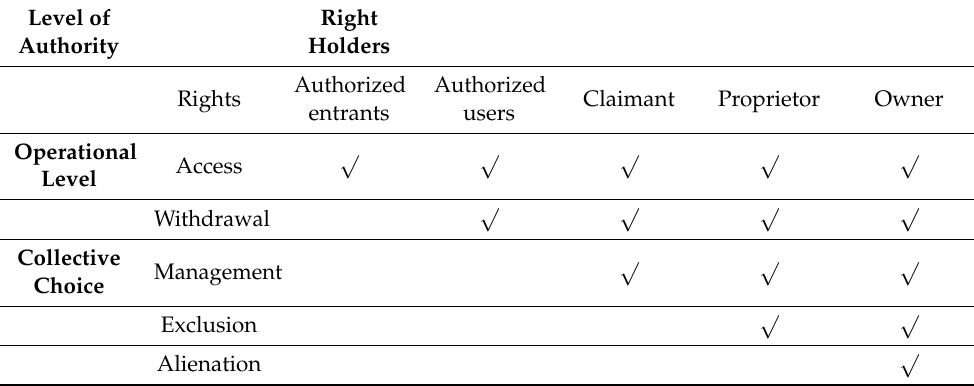
Table 1. Bundle of Rights